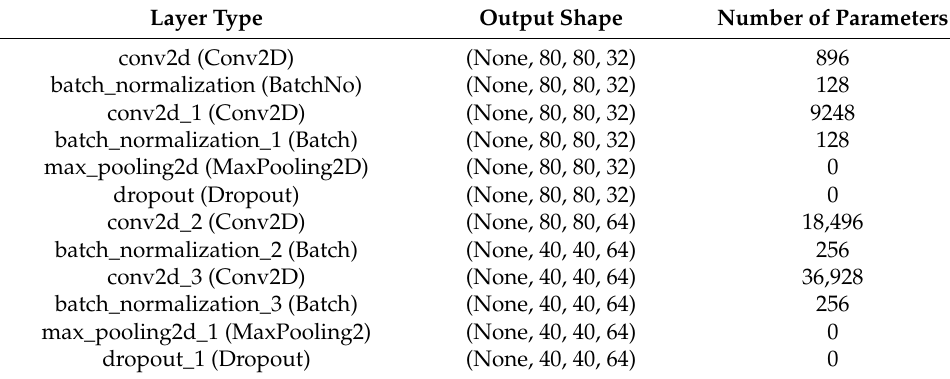
Table 3. CNN architecture for an 80 × 80 input image.